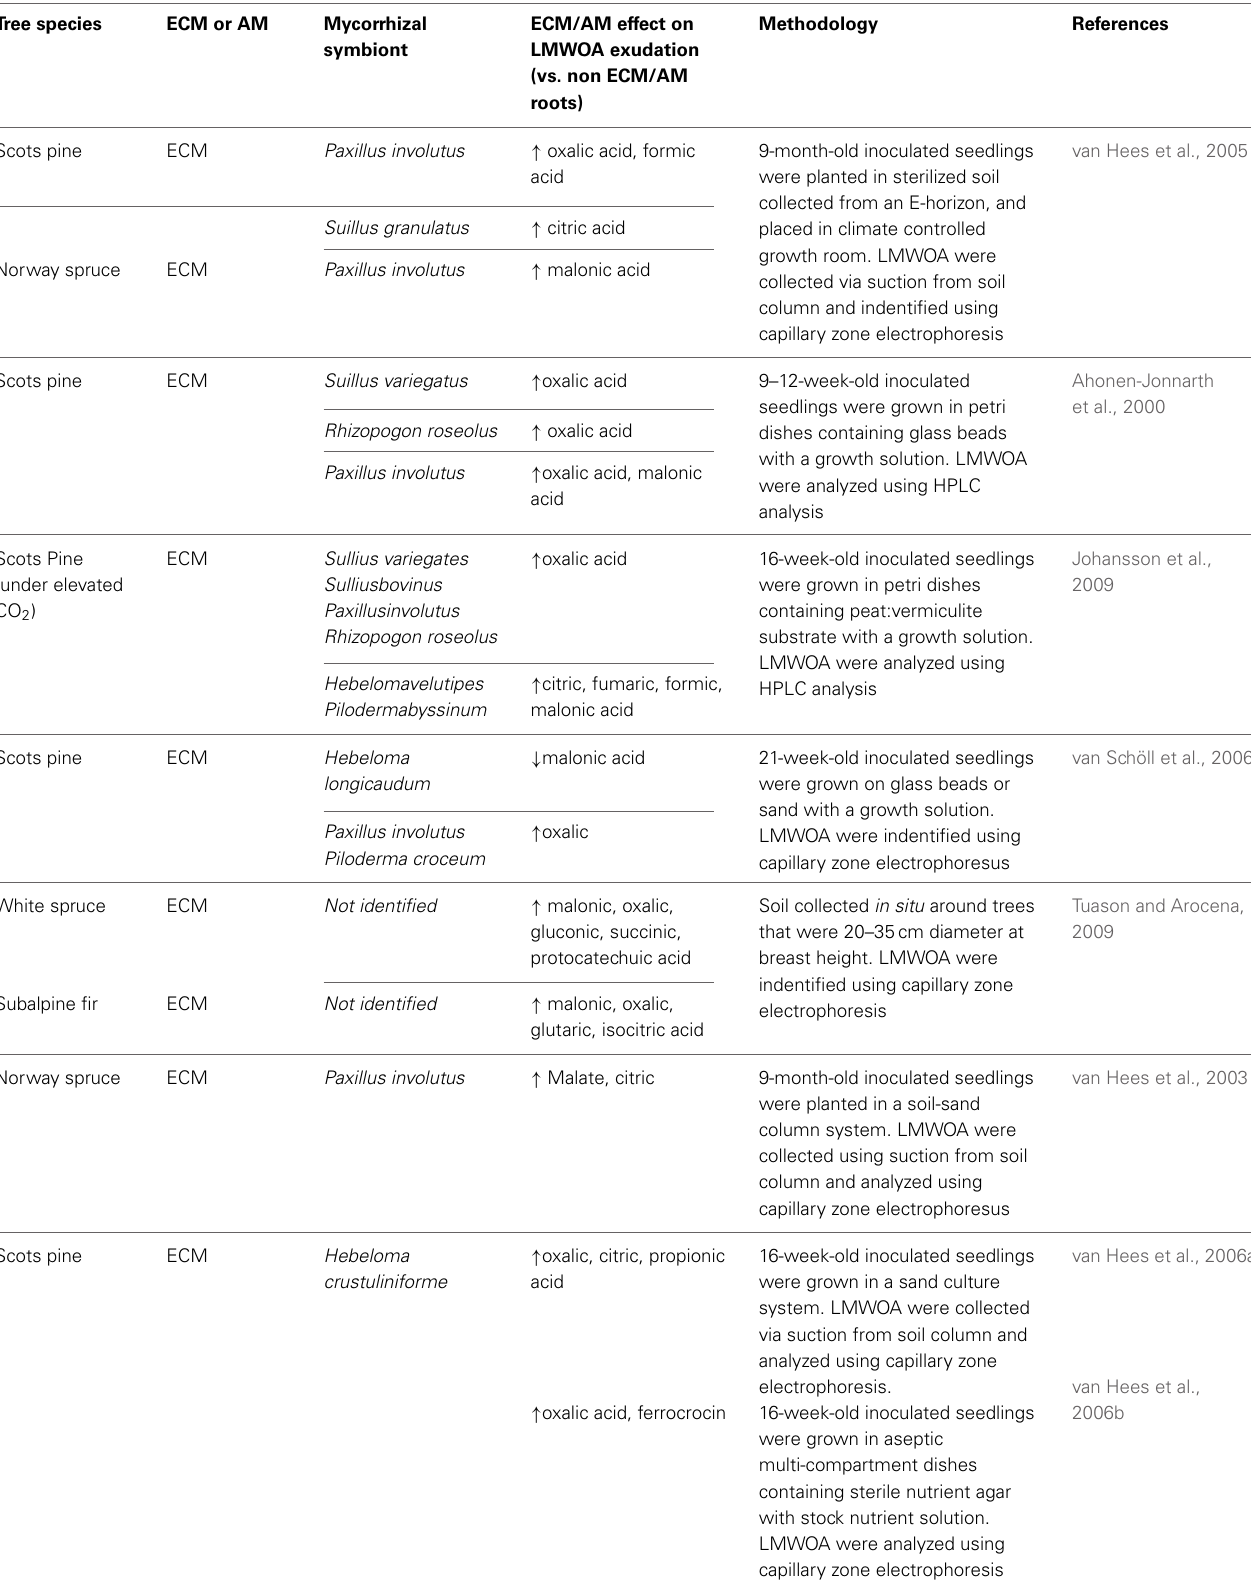
Table 2 | Modification of low molecular weight organic acid (LMWOA) exudates from trees by different ectomycorrhizal (ECM) and arbuscular mycorrhizal (AM)